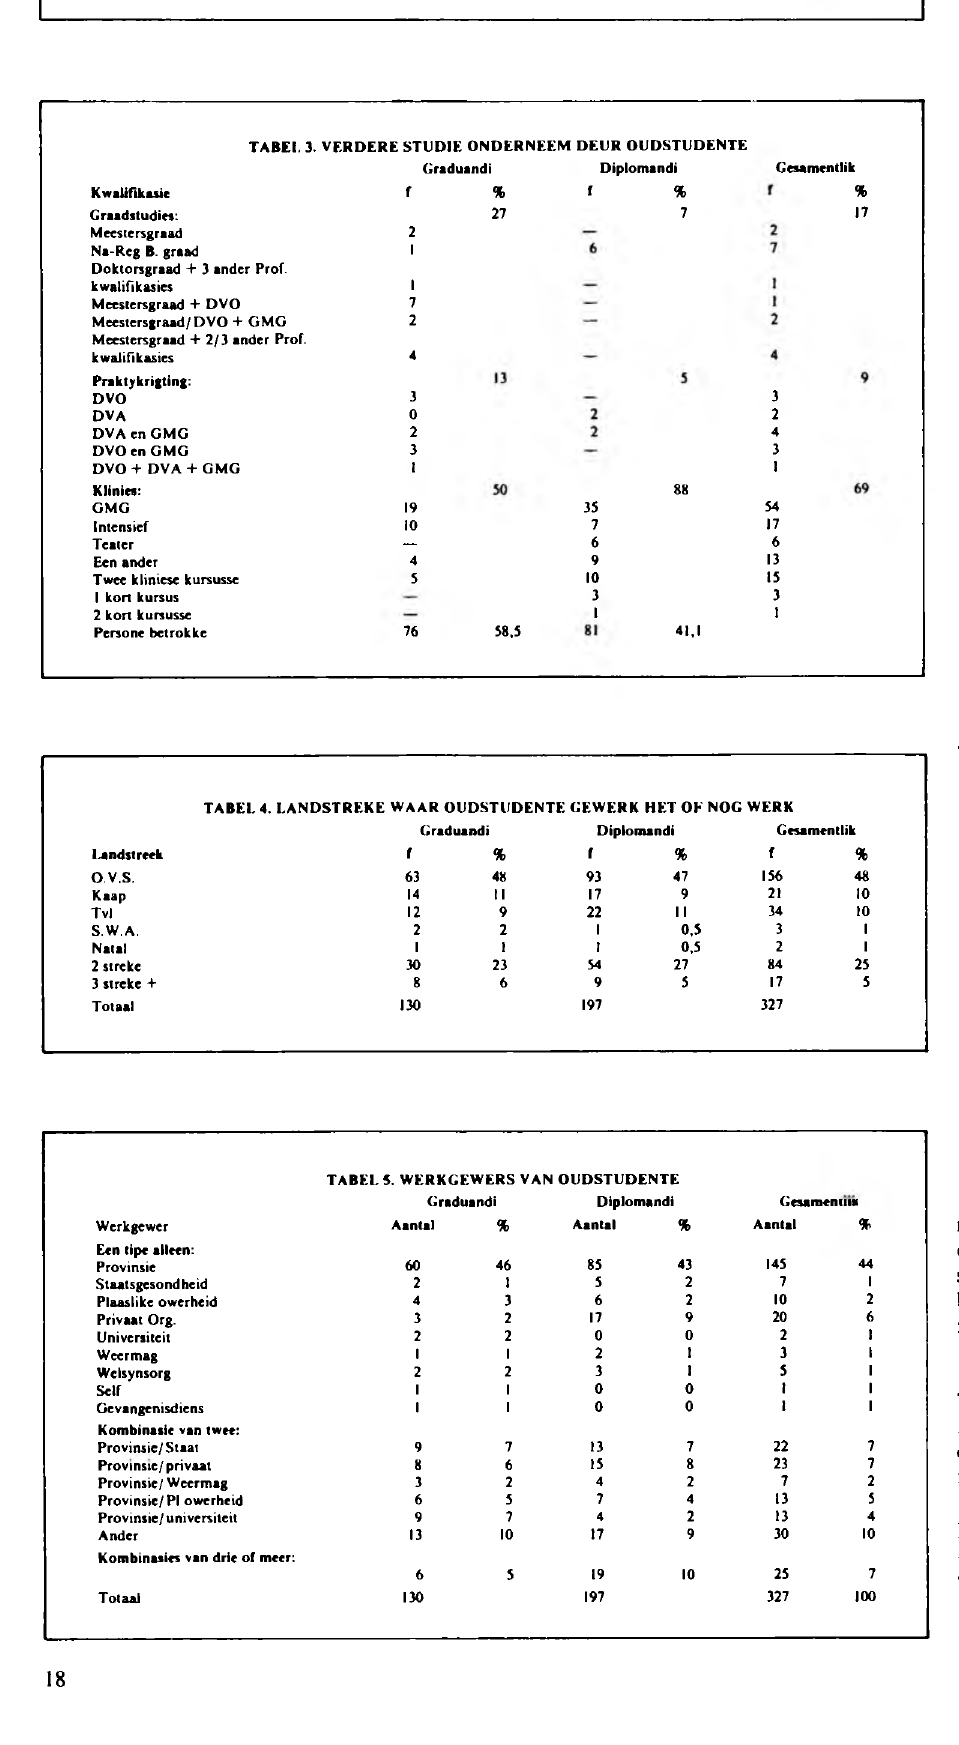
TABEL 3. VERDERE STUDIE ONDERNEEM DEUR OUDSTUDENTE